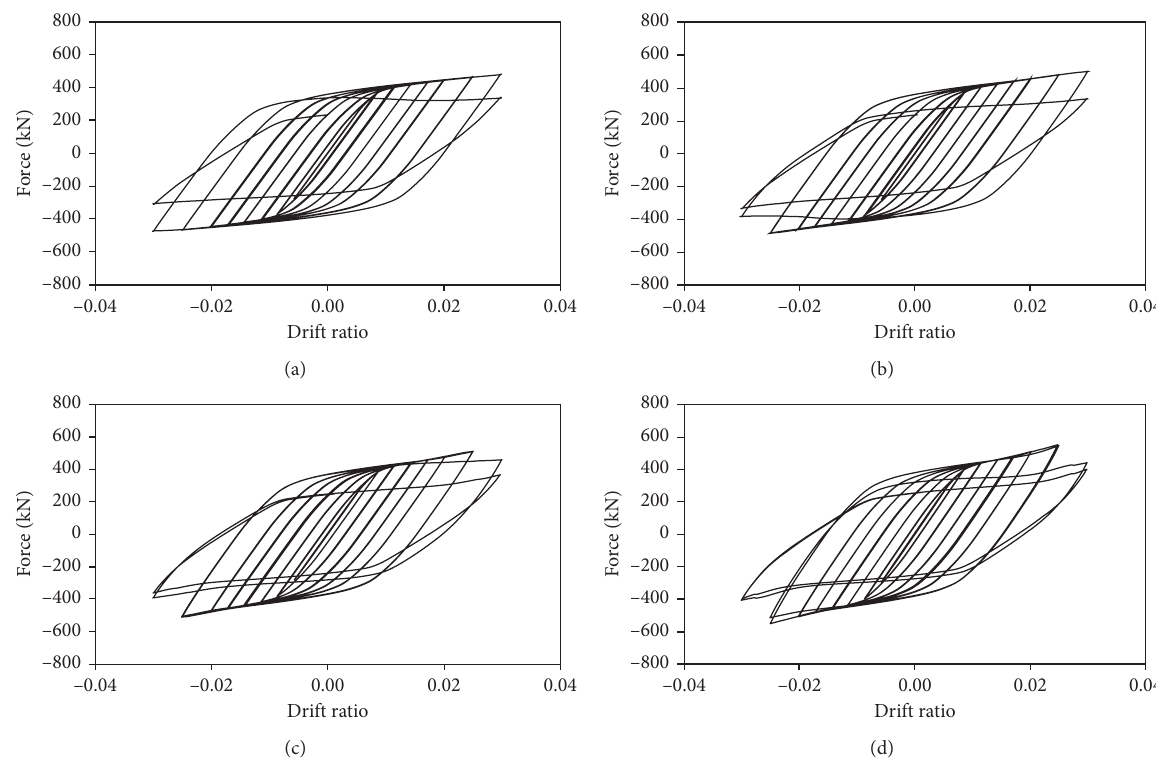
Figure 13: Hysteresis curves of beam-only-connected H-CSPSWs for different plate thicknesses. (a) t � 0.5mm. (b) t � 1.0mm. (c) t � 1.5 mm. (d) t � 2.0mm.